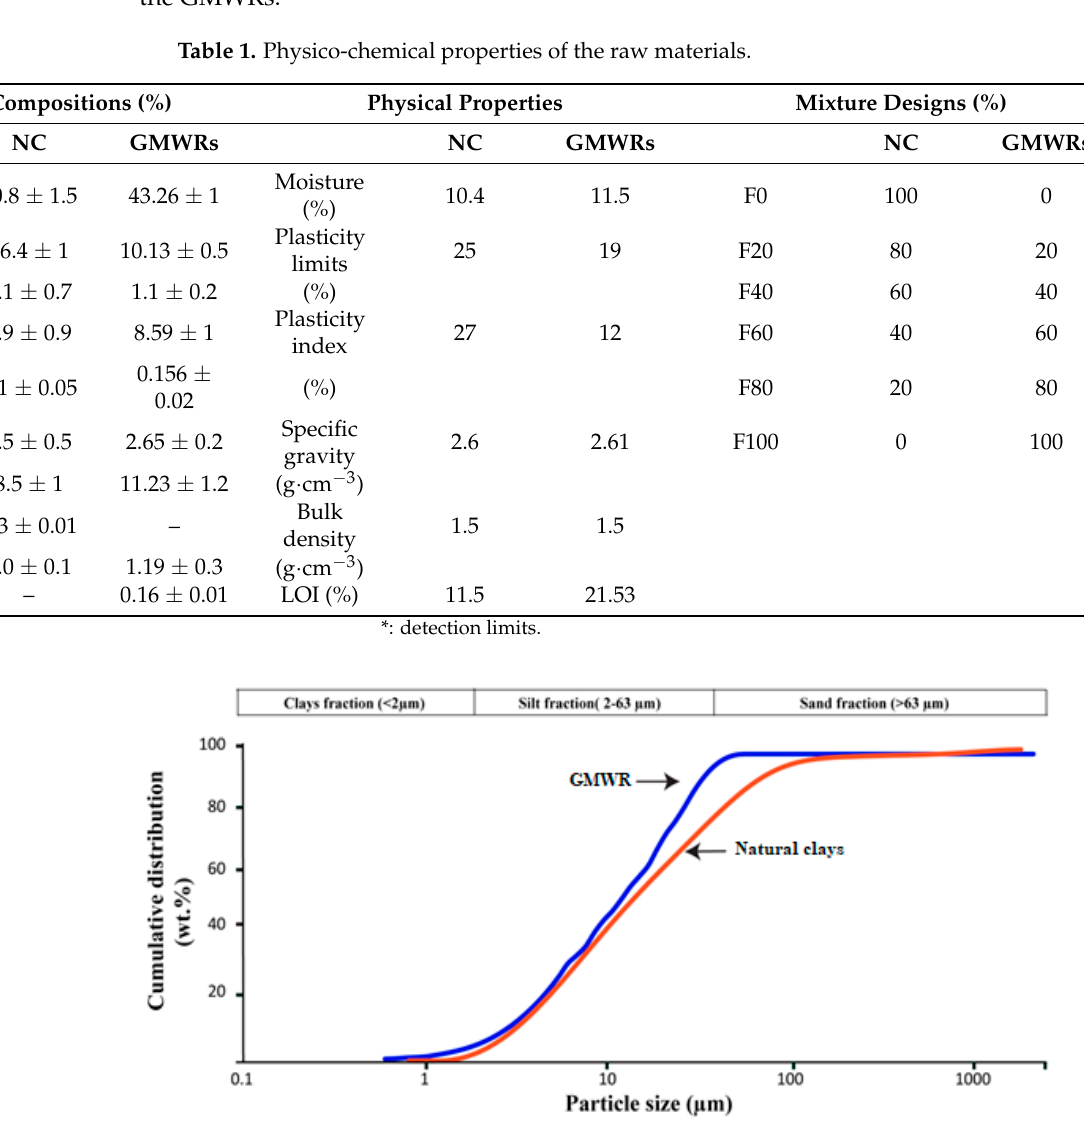
Figure 3. Particle size distribution of the GMWRs and